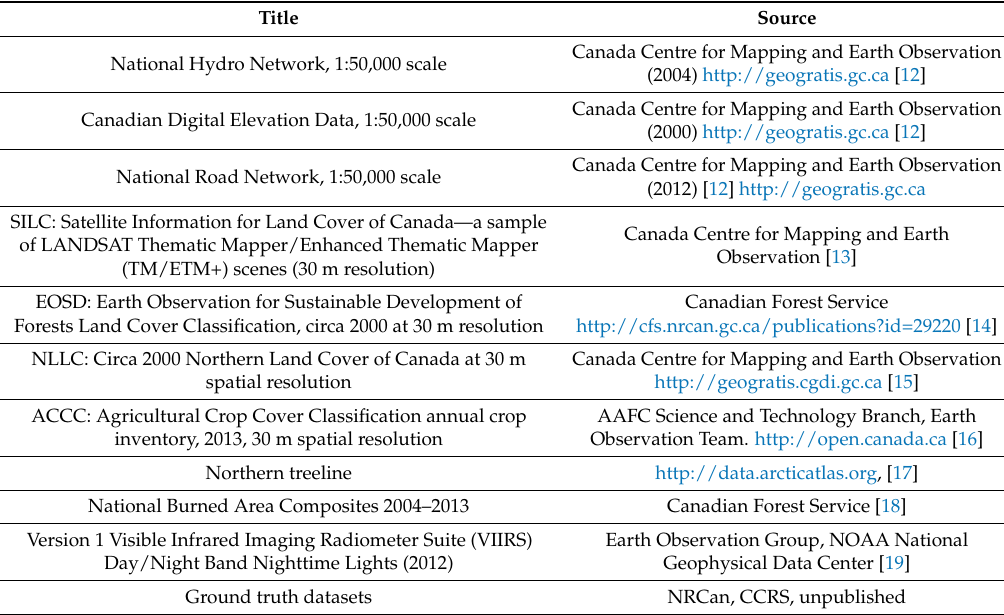
Table 2. Ancillary data used as aid for generating classifier-training data. Title Source Canada Centre for Mapping and Earth Observation National Hydro Network, 1:50,000 scale (2004) http://geogratis.gc.ca [12] Canadian Digital Elevation Data, 1:50,000 scale Canada Centre for Mapping and Earth Observation National Road Network, 1:50,000 scale (2012) [12] http://geogratis.gc.ca SILC: Satellite Information for Land Cover of Canada—a sample Canada Centre for Mapping and Earth of LANDSAT Thematic Mapper/Enhanced Thematic Mapper Observation [13] (TM/ETM+) scenes (30 m resolution) EOSD: Earth Observation for Sustainable Development of Canadian Forest Service Forests Land Cover Classification, circa 2000 at 30 m resolution http://cfs.nrcan.gc.ca/publications?id=29220 [14] NLLC: Circa 2000 Northern Land Cover of Canada at 30 m Canada Centre for Mapping and Earth Observation spatial resolution http://geogratis.cgdi.gc.ca [15] ACCC: Agricultural Crop Cover Classification annual crop inventory, 2013, 30 m spatial